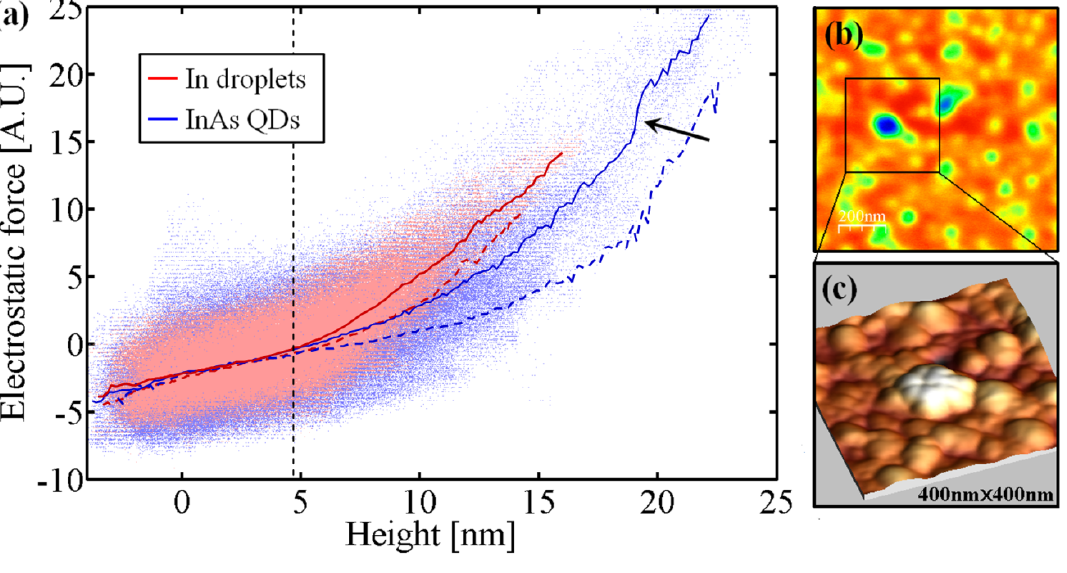
Figure 4. ( a ) Scatter plot of EFM signal vs . height for In droplets (pink) and InAs QDs (light blue) on GaSb substrate. The solid lines represent the average at a given height. The dashed lines are the averages obtained for measurements with a positive tip voltage (scatter plot not shown). The sudden “jump” marked by the arrow, occurs due to points corresponding to the area highlighted in the EFM scan image shown in ( b ). A closer look at the topography of the area is shown in ( c